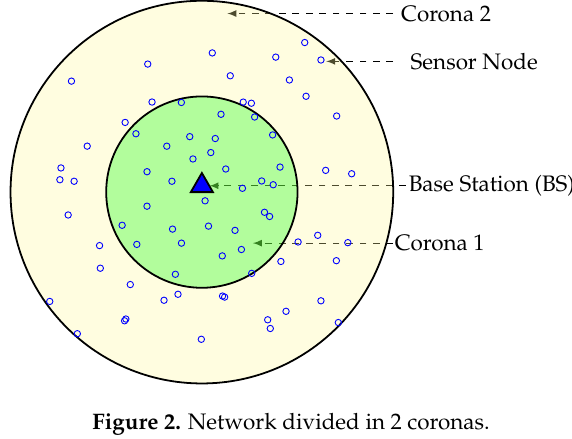
Figure 2. Network divided in 2 coronas.